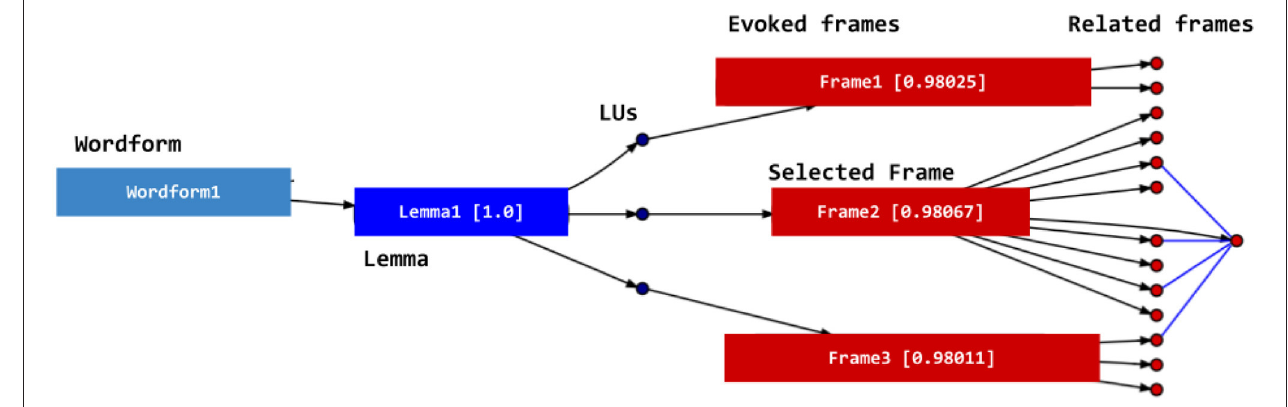
FIGURE 12 | The spread activation process in DAISY.